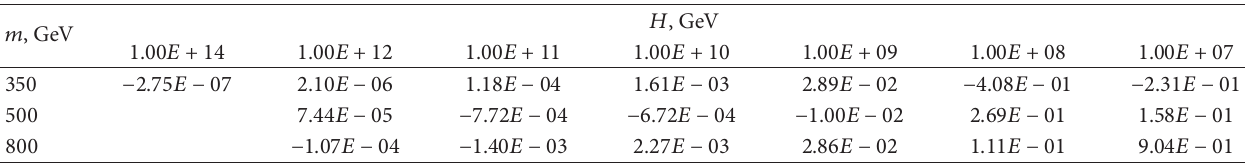
Table 1: The baryon charge 𝐵 contained in the SFC at the time of its decay for different 𝐻 𝐼 and 𝑚 and fixed set of 𝜆 1 = 10 −2 , 𝛼 = 10 −2 , 𝜆